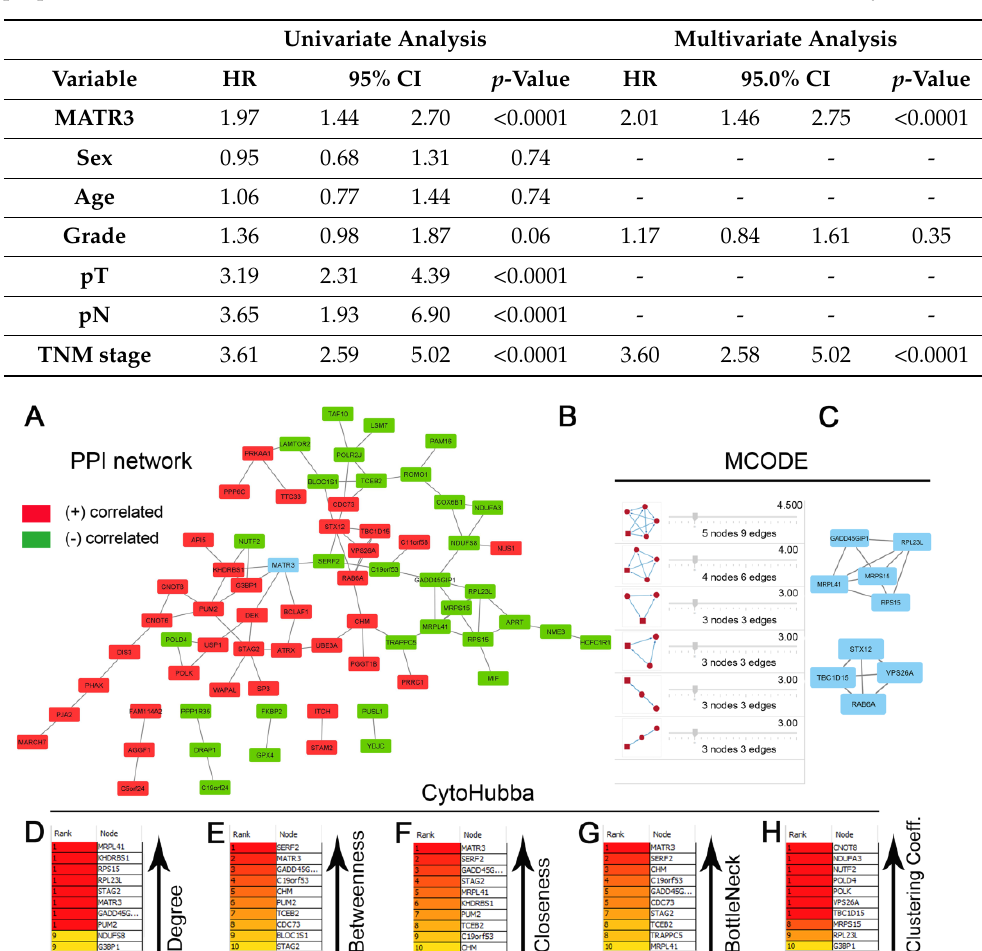
Figure 3. Protein – protein interaction (PPI) network for the top genes positively or negatively corre- lated with MATR3 in clear cell renal cell carcinoma (ccRCC) ( A ). The nodes and edges are retrieved from the STRING database and plotted using Cytoscape software. The red nodes represent MATR3 positively correlated genes, and the green nodes represent MATR3 negatively correlated genes. MATR3 is highlighted in blue. Disconnected nodes were hidden. The top 10 hub genes identified by CytoHubba Cytoscape plugin are ranked according to degree centrality ( B ), betweenness centrality ( C ), closeness centrality ( D ), bottleneck ( E ), and clustering coefficient ( F ). The six modules identified in the PPI network using the MCODE Cytoscape plugin ( G ). The top two modules identified from the PPI network could be seen ( H ). Figure prepared using Adobe Photoshop